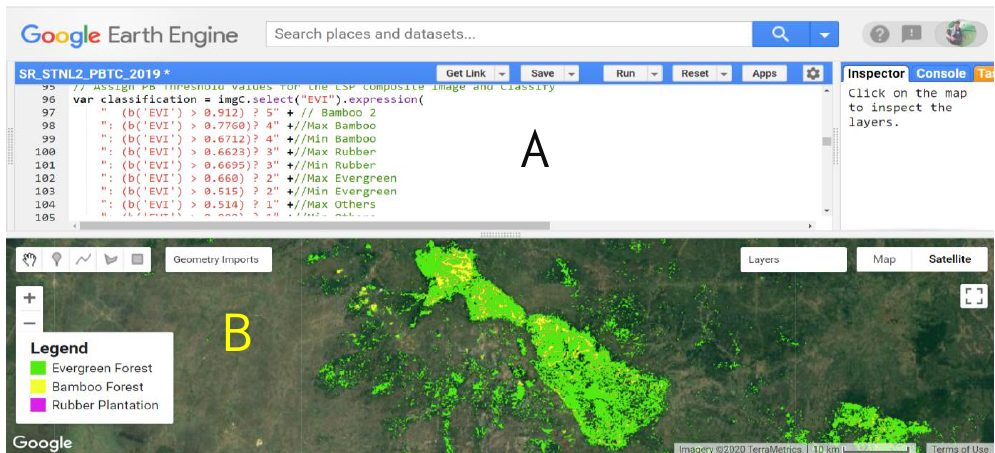
Figure 4. Example result of Sentinel-2 imagery phenology-based threshold classified map. Legend: ( A ) Code window showing the PBTC functions developed in GEE. ( B ) Map window that represents the 10 m resolution Sentinel-2 land use map in 2019. Bamboo forest appears in yellow (inset legend). The background image is GEE Google Earth imagery.